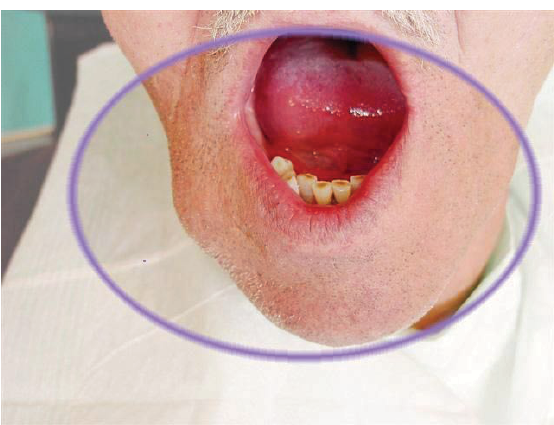
Figure 1. Right face swelling caused by a tumor-like lesion in the right buccal area.